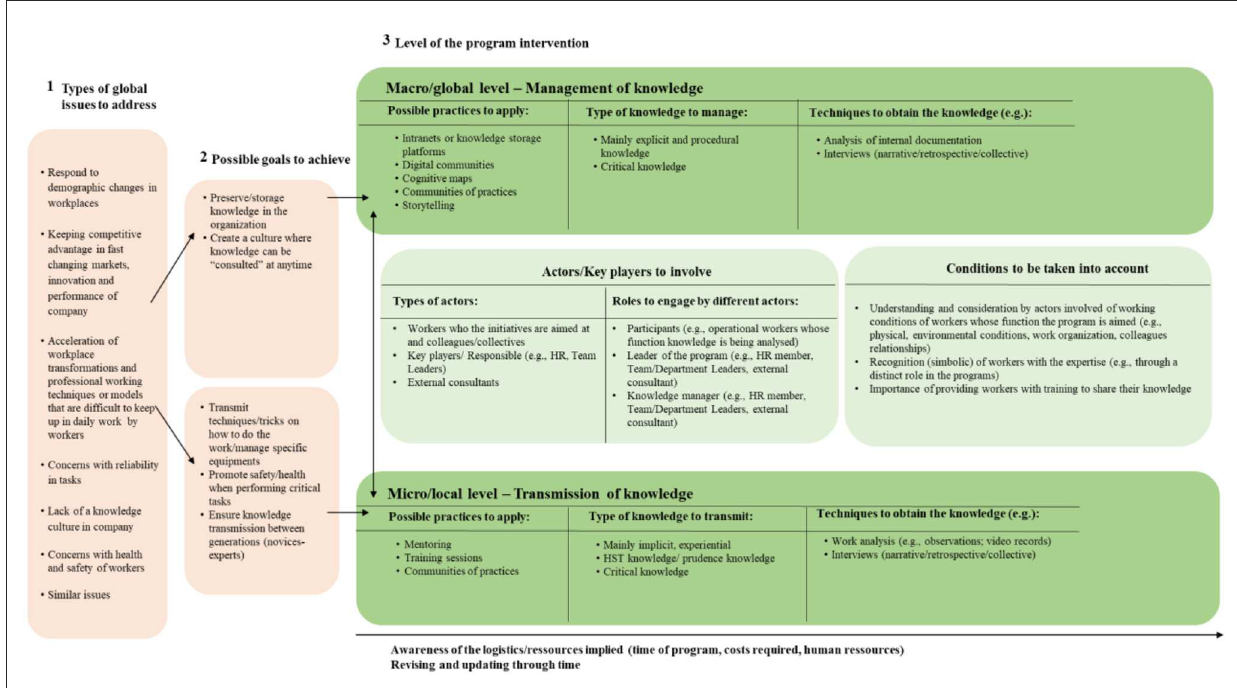
FIGURE2 Theoretical framework for the design and implementation of a management or transmission of knowledge